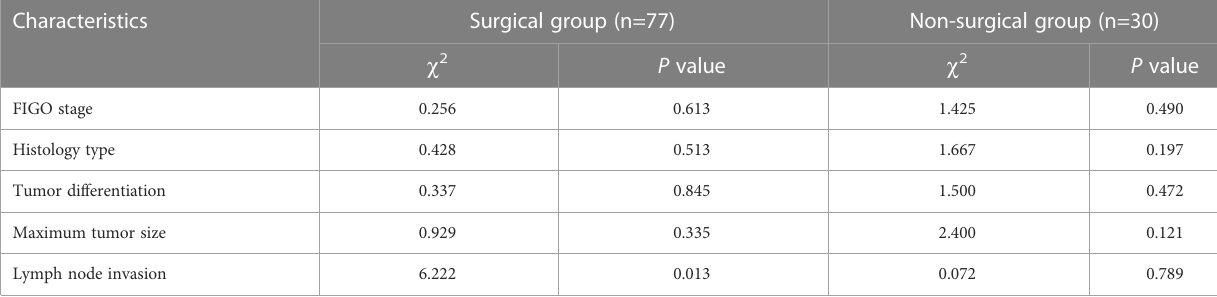
FIGO, International Federation of Gynecology and